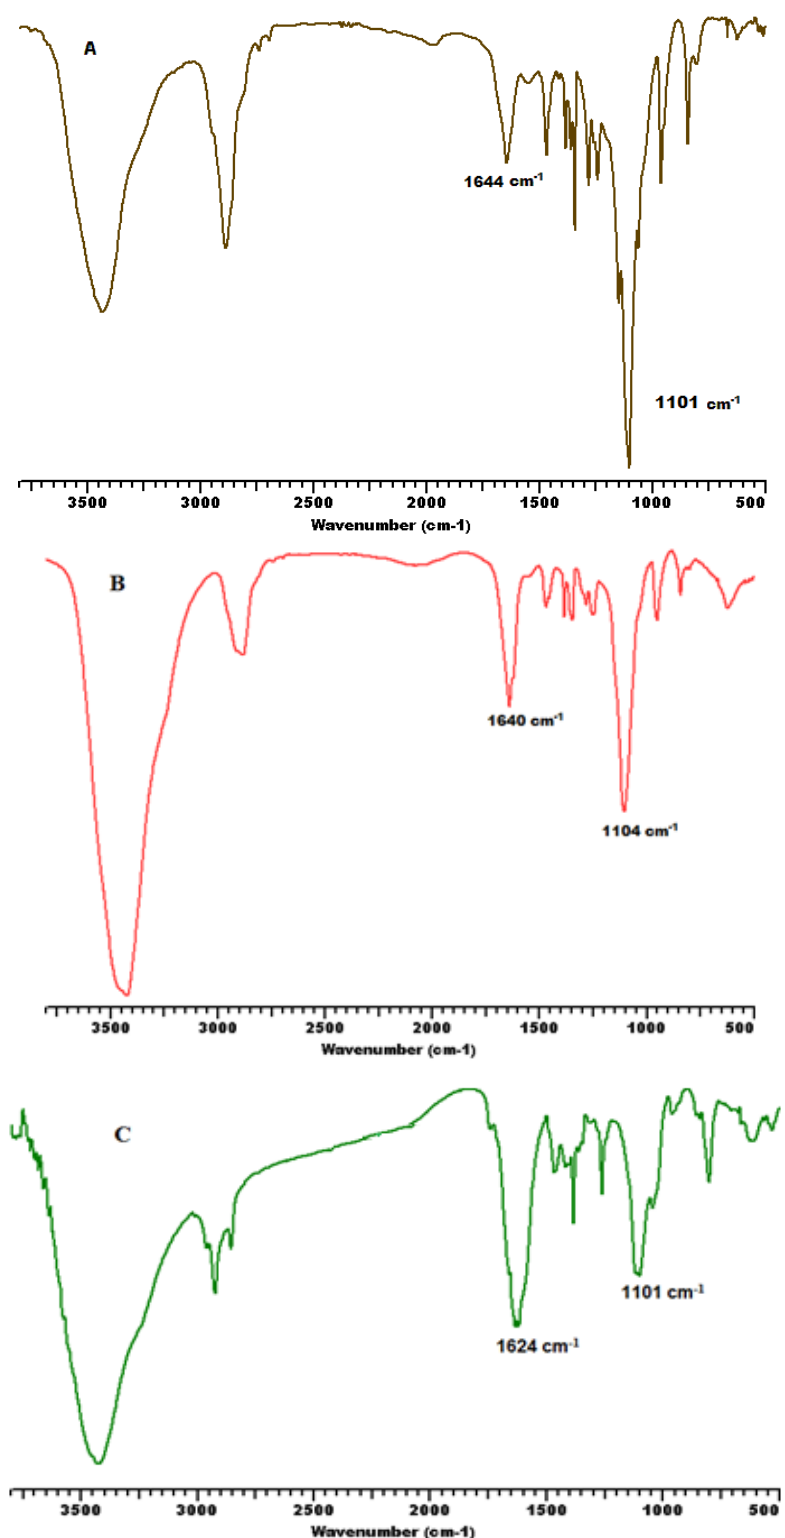
Figure 1. FT-IR spectra of m -PEO- b -poly(His- co -Gly) with ( A ) 10% glycine to histidine molar ratio; ( B ) 20% of glycine to histidine molar ratio; ( C ) 40% glycine to histidine molar ratio.